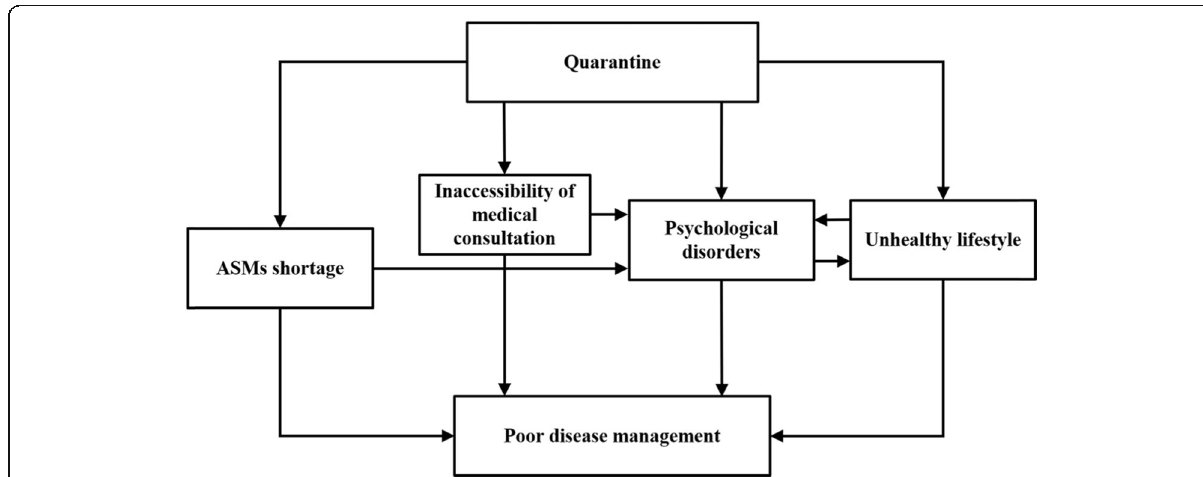
Fig. 1 Summary of the most-frequently suggested impacting factors on epilepsy care during the COVID-19 pandemic. ASMs, antiseizure